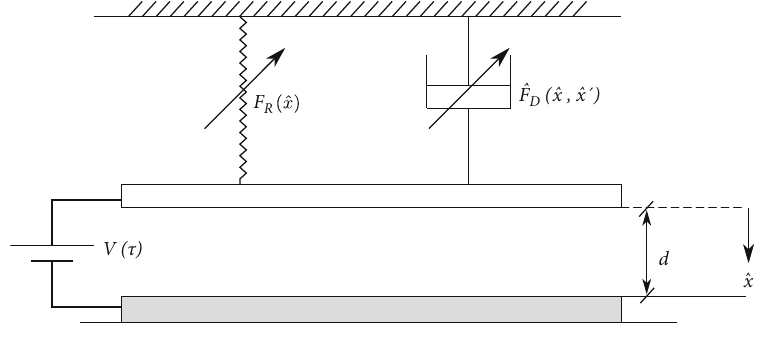
Figure 1: Parallel plate capacitor with one movable plate.